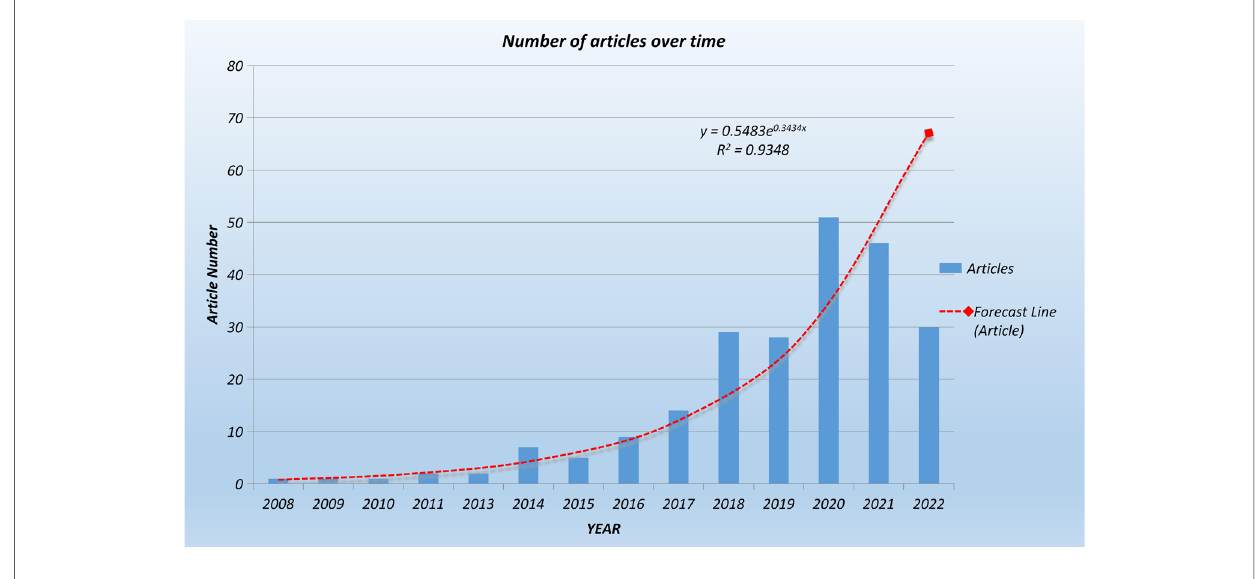
FIGURE 1 Changes in the number of articles linked to TOET over time. The red dotted line is the forecast line, and the red square represents the forecast document volume in 2022. From 2008 to 2016, the number of studies per year was below 10. Rapid growth from 2017 onward, the number of studies published per year is above 28, reaching 51 in 2020. Based on the prediction curve (red dashed line), it is predicted that 68 studies may come out in